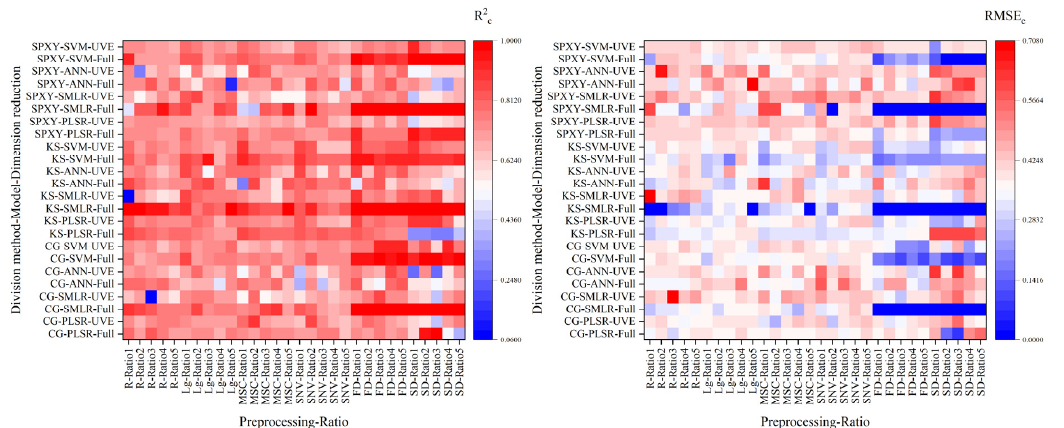
Figure 8. Accuracy of calibration set model.